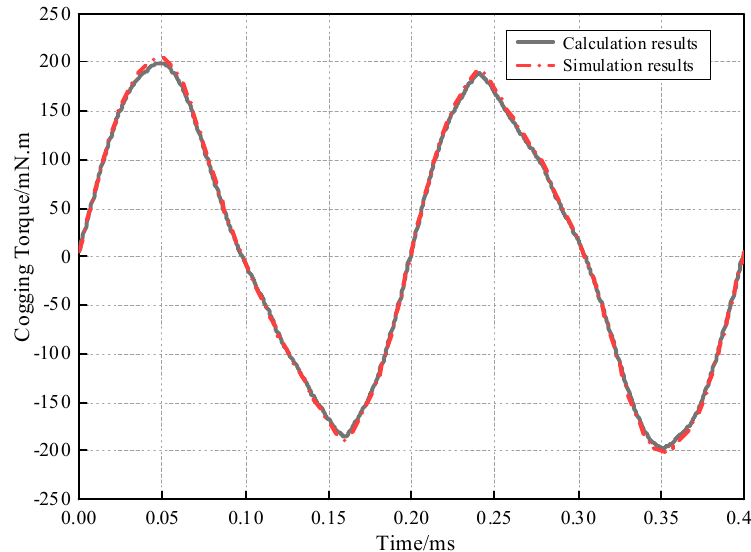
Figure 12. Comparison of cogging torque between calculation results and simulation results.